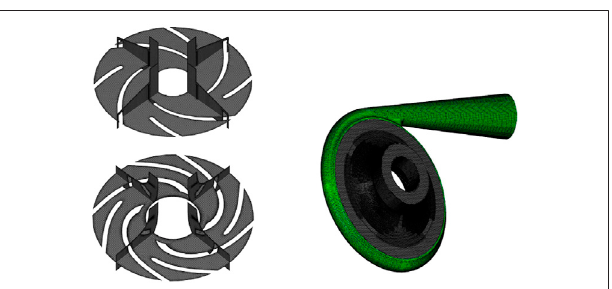
FIGURE 4 | Computation grid of the centrifugal pump.